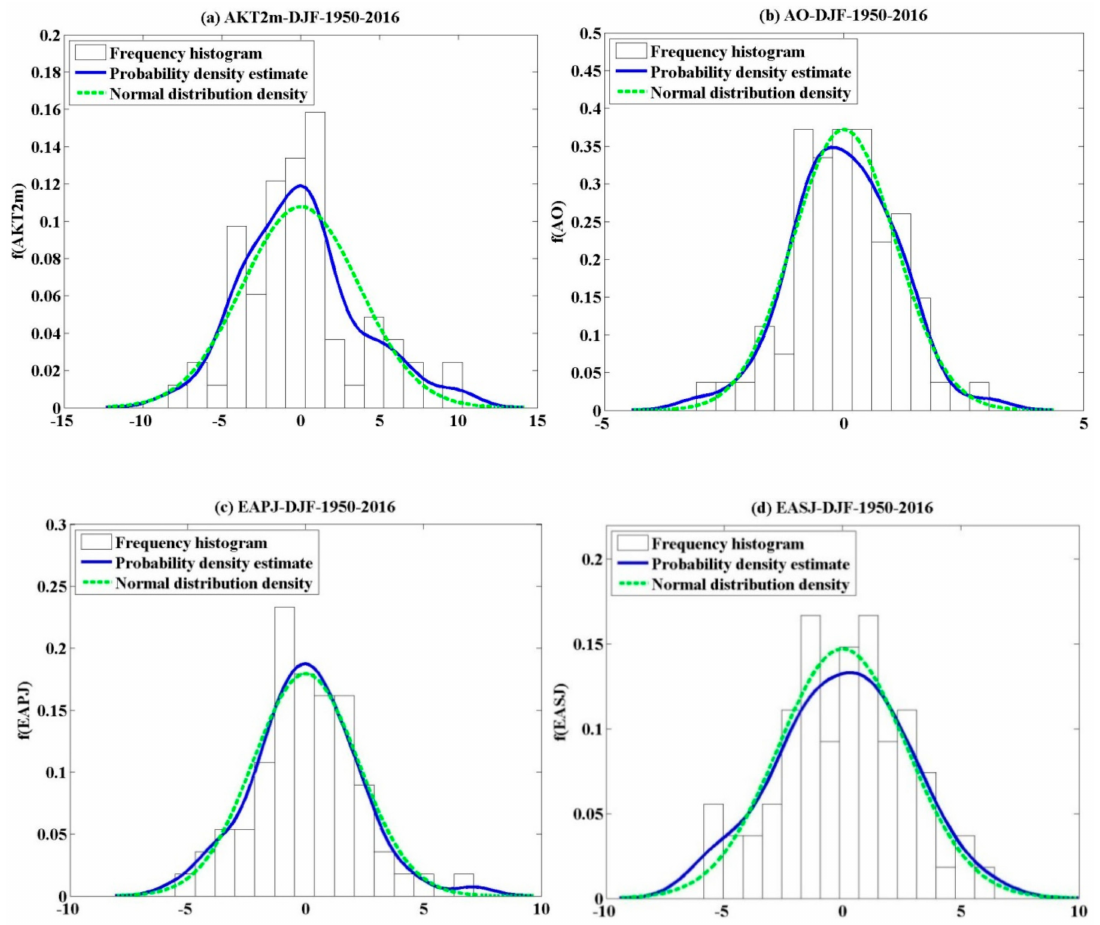
Figure 1. Frequency histogram, probability density estimate (blue solid line), and normal distribution density (dashed green line) for the ( a ) Arctic key temperature at 2 m (AKT2m), ( b ) Arctic Oscillation, ( c ) East Asian polar front jet stream (EAPJ), and ( d ) East Asian subtropical jet stream (EASJ) during